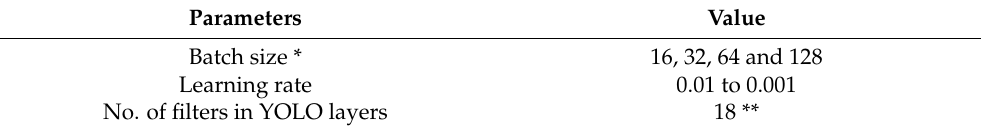
Table 1. Selection of